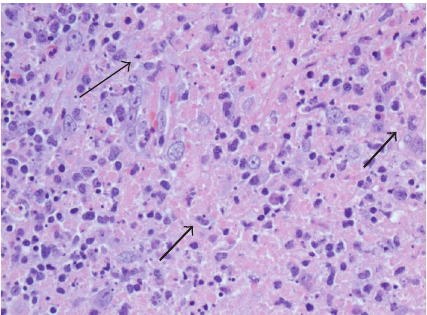
F 3: 400� magni�cation of cervical lymph node biopsy showingdisruptedarchitecture,paracorticalexpansionwithareasof necrosis and nuclear debris (thin arrow). Plasma cells and numerous histiocytes (thick arrows) present. Above �ndings are